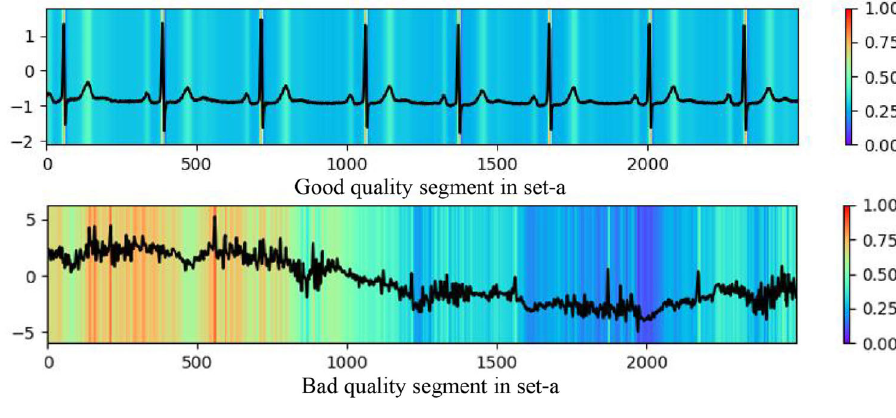
Fig. 7 An example of good and bad quality segments selected from set-a and their corresponding heatmaps